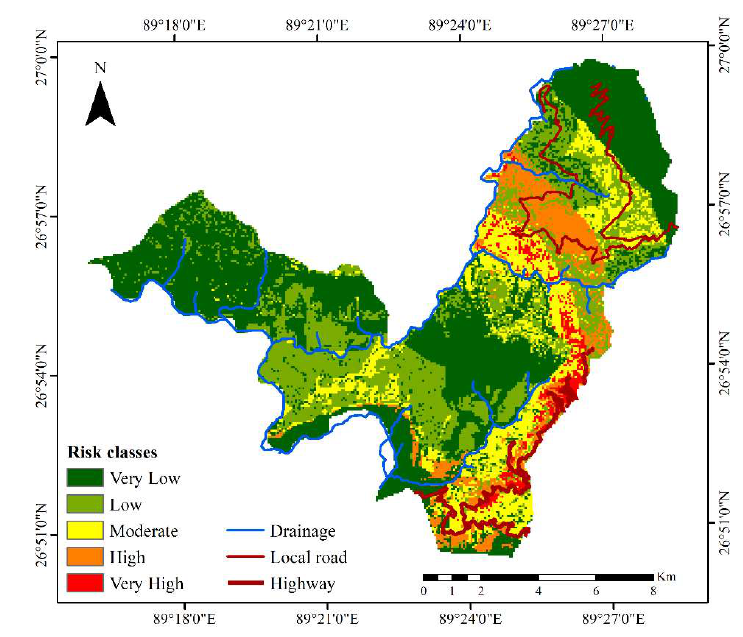
Figure 8. Landslide risk map of the study region. Table 3. Area a ff ected by various risk zones for all six chiwogs. Table 2. Area and population distribution with respect to risk zones.